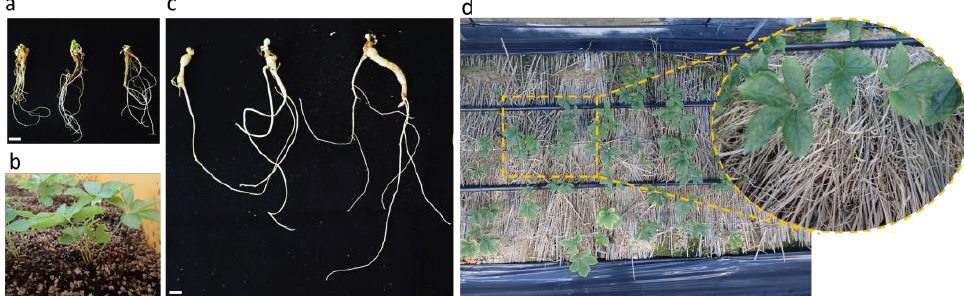
Figure 6. Acclimatization of in vitro grown roots (IGRs) in P. ginseng cv. Cheonryang. ( a ) IGRs before soil transfer, ( b ) Sprouted IGRs in a greenhouse, ( c ) Harvested 2-year-old IGRs after acclimatization